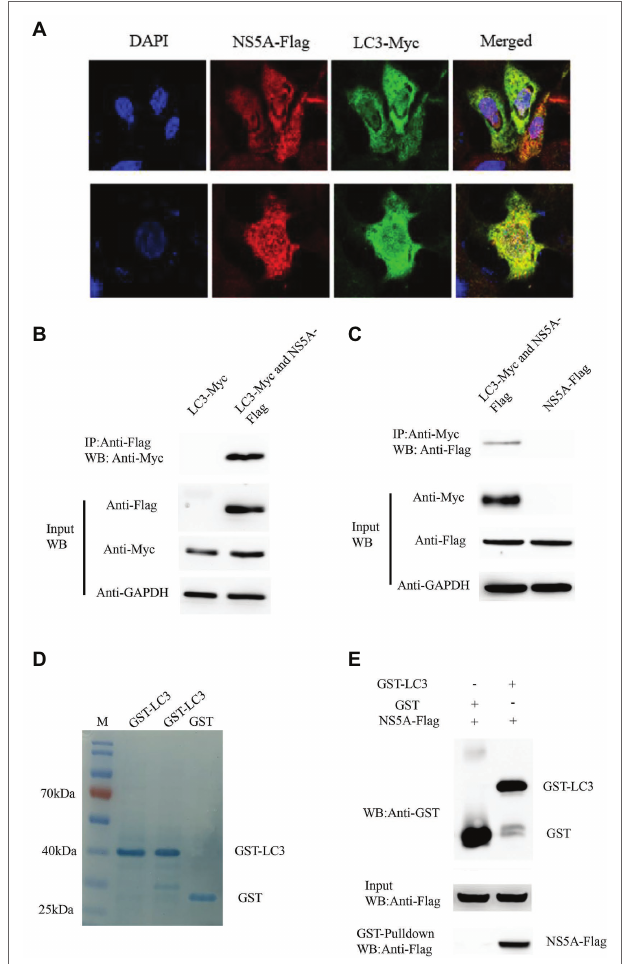
FIGURE 4 | Classic swine fever virus NS5A interacts with LC3. (A) NS5A co-localization with LC3 protein. PK-15 cells were cotransfected with NS5A-Flag and LC3-Myc and analyzed by laser confocal microscopy after 48 h. All cells were stained with DAPI. (B) Coimmunoprecipitation assay